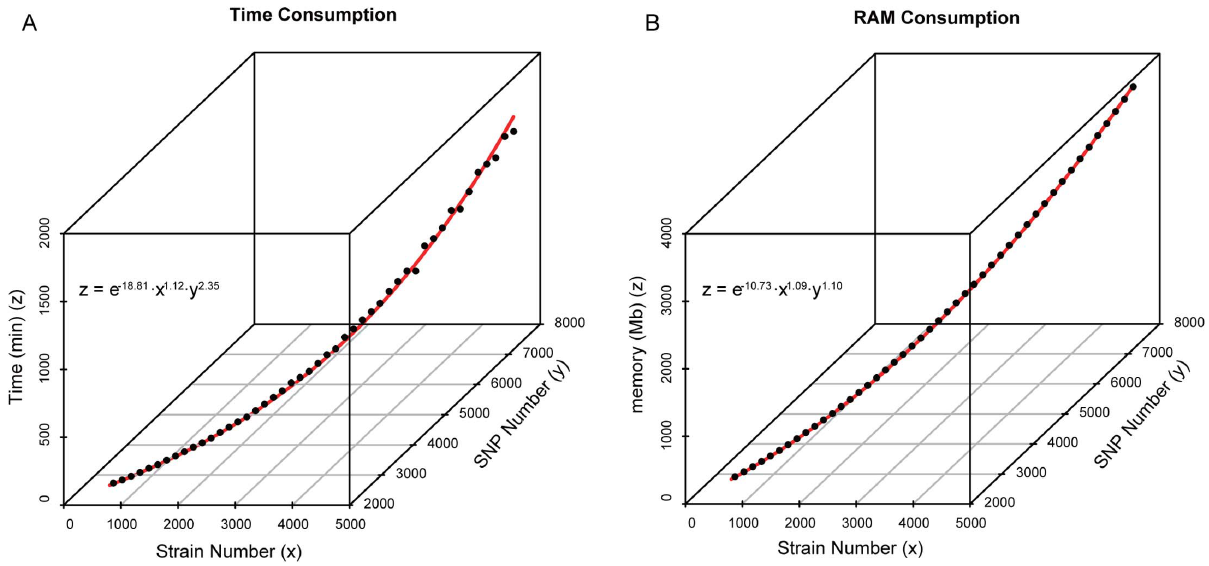
Figure 1. CPU running time and RAM consumption of phylogenetic reconstruction based on simulated mega dataset. The points represent the CPU running time (panel A) and RAM consumption (panel B) for reconstructing the MLTree based on different numbers of genomes and variations. The red curves represent the changes of both running time and RAM consumption, which follow the power function according to the formulas in the figure.